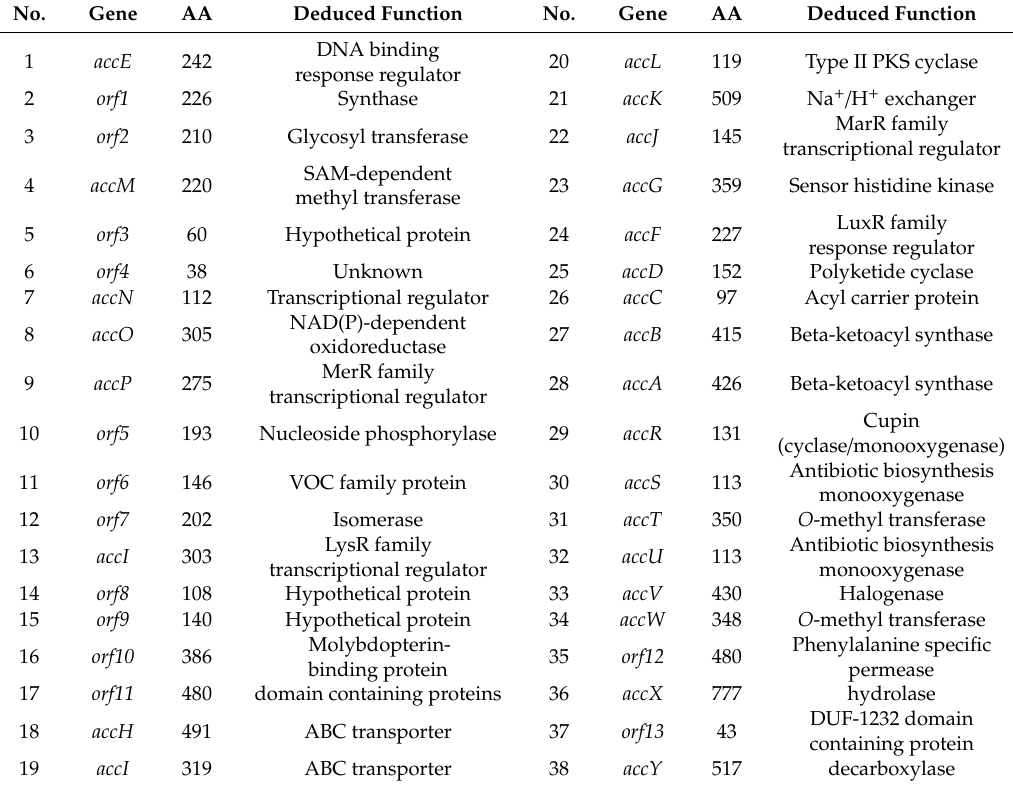
Figure 2. ( A ) Accramycin ( acc ) biosynthetic gene cluster in Streptomyces sp . MA37. ( B ) Proposed biosynthetic pathway of 1 . Table 2. Deduced functions of open reading frames (ORFs) in accramycin ( acc ) biosynthetic gene cluster.